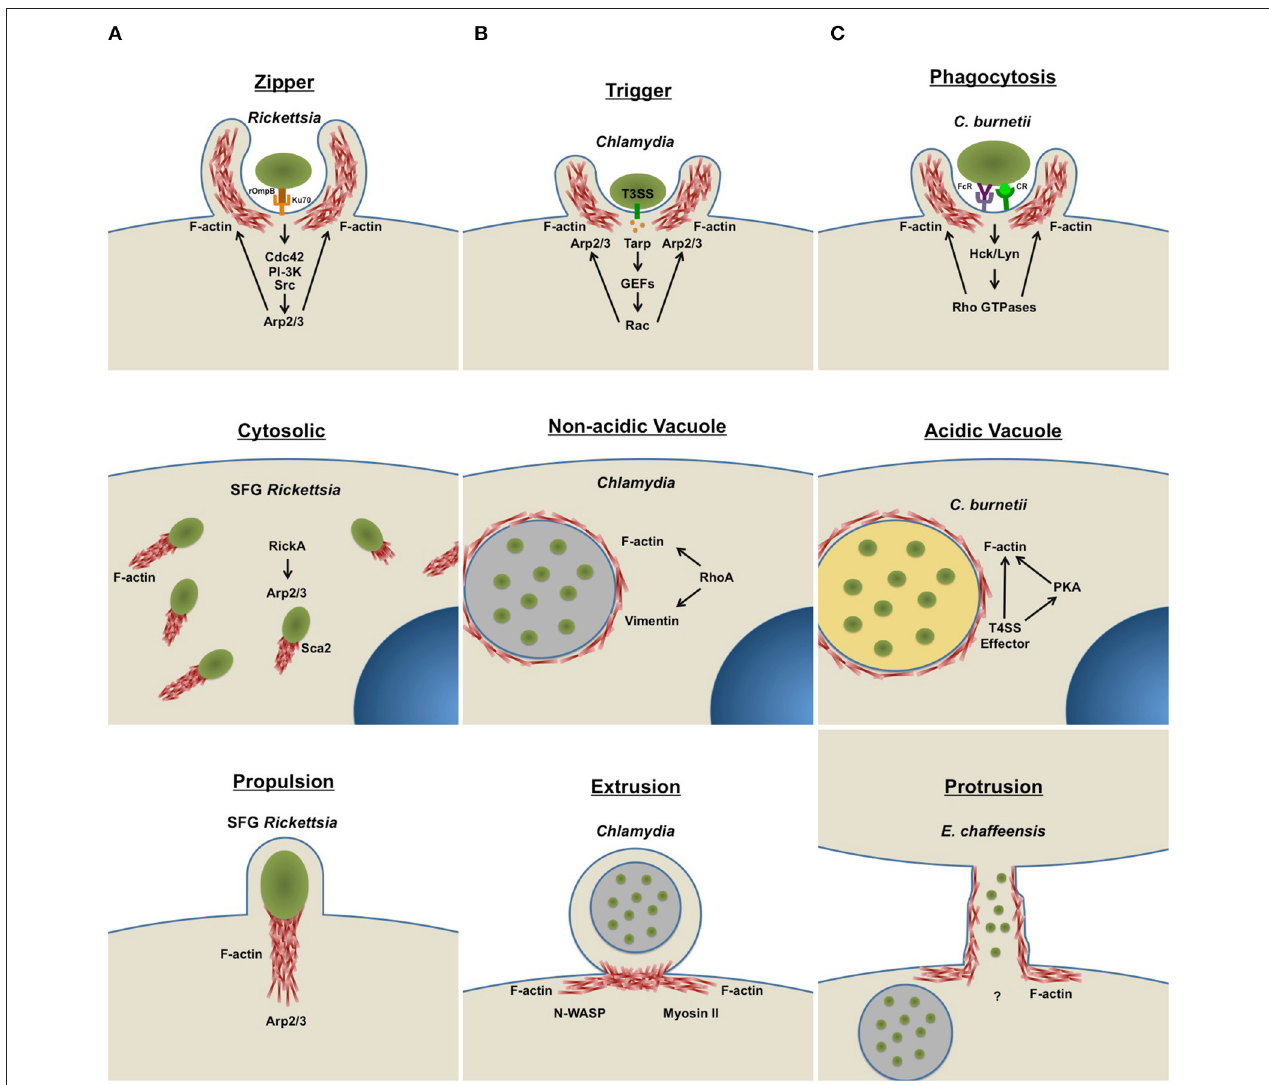
FIGURE 1 | Intracellular bacteria use host actin for diverse infection events. Intracellular bacteria actively manipulate the host actin cytoskeleton to facilitate major lifecycle events, such as cellular invasion, intracellular replication, and dissemination. Arrows indicate activation of specific host cell components. (A) Host cell entry: In non-phagocytic cells, bacteria use a zipper ( Rickettsia ) or trigger ( Chlamydia ) mechanism to facilitate infection. Phagocytic cells engulf bacterial pathogens ( C. burnetii and E. chaffeensis ) by phagocytosis. To promote uptake, bacteria actively remodel actin at the attachment site by activating host kinase signaling cascades. (B) Intracellular life: Some cytosolic bacteria (SFG Rickettsia ) form actin tails to facilitate mobility within the cell. Pathogens that reside within membrane-bound vacuoles ( Chlamydia, C. burnetii , and E. chaffeensis ) manipulate the cytoskeleton to facilitate vacuole formation and stability. (C) Host cell